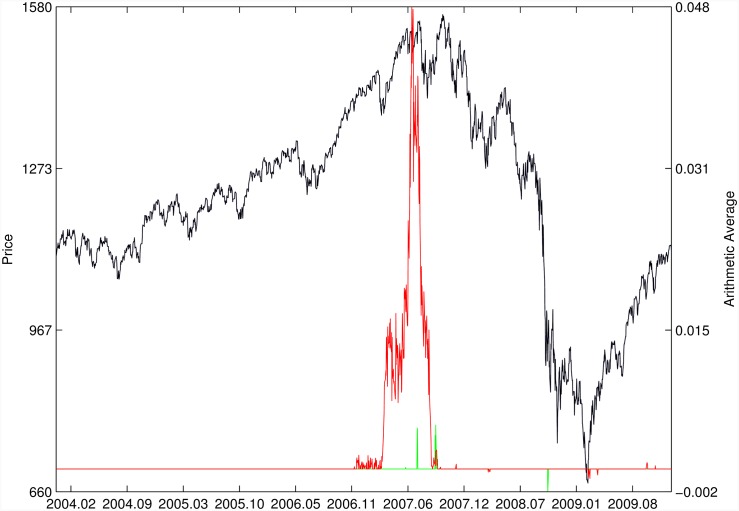
S&P 500 2007.Same as Fig 10.